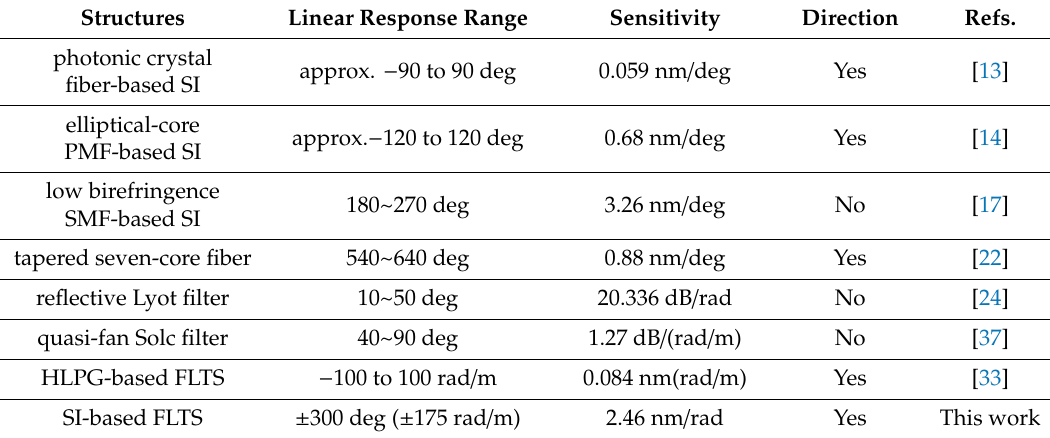
Figure 10. The torsion responses with varied ambient temperature. Table 1. Comparisons of fiber torsion sensors. HPLG: helical long-period gratings.